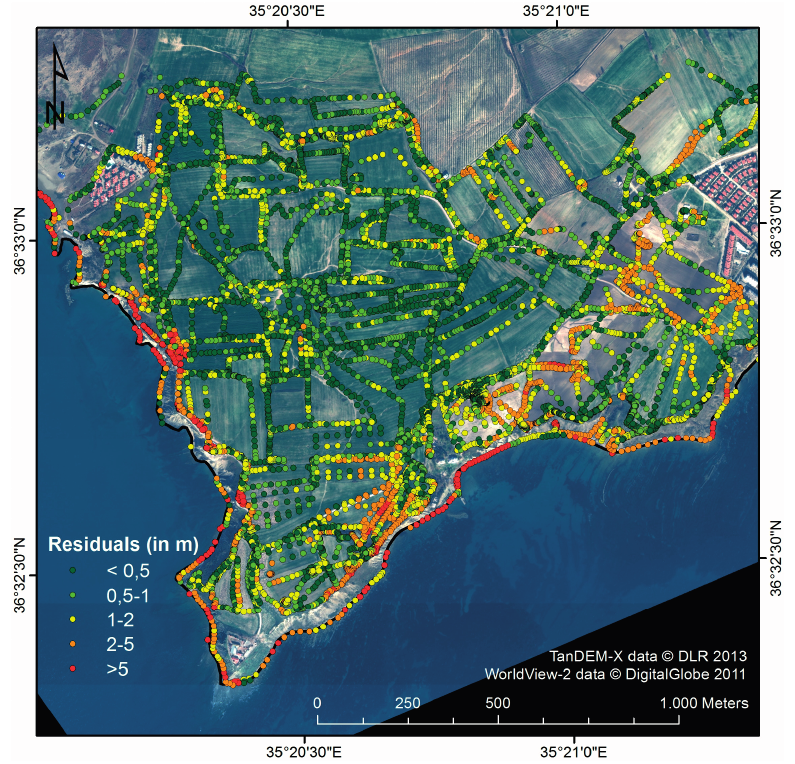
Figure 7. Accuracy assessment of TanDEM-X HS alternating bistatic (ALT-2) DEM for the study area around Cape Karata ş . The color of the dots represents the residuals (absolute height errors) of final DEM compared to RTK-GPS field survey.